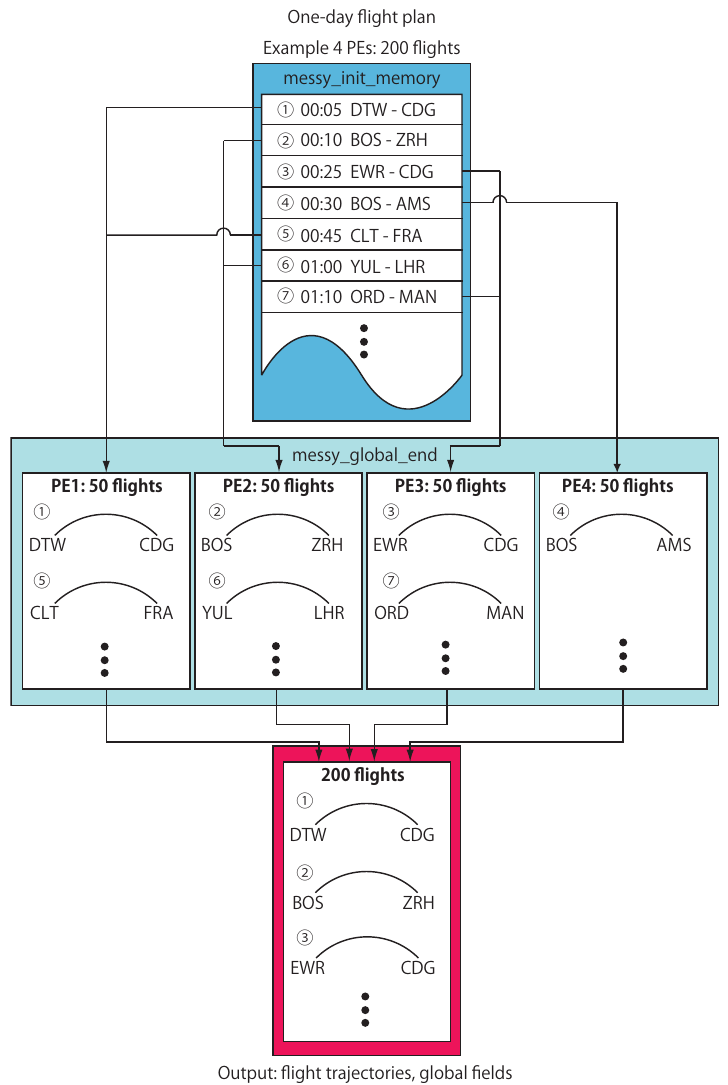
Figure 2. Decomposition of global flight plans in a parallel environment of EMAC/AirTraf. A 1-day flight plan is distributed among many processing elements (PEs) in messy_init_memory (blue). A whole trajectory of an airport pair is handled by the same PE in the time loop of EMAC ( messy_global_end , light blue). Finally, results are gathered from all the PEs for output (rose